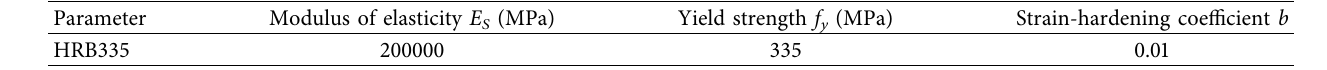
Table 1: Material parameter value of steel